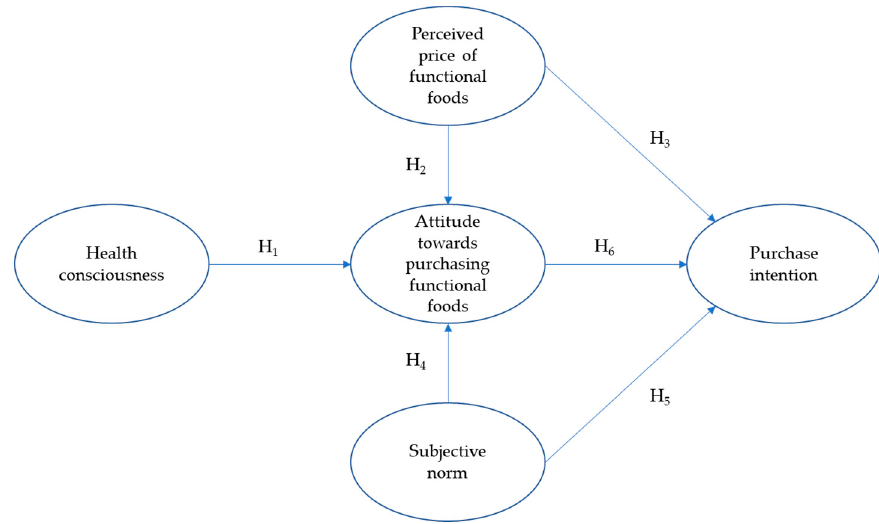
Figure 2. Research model.